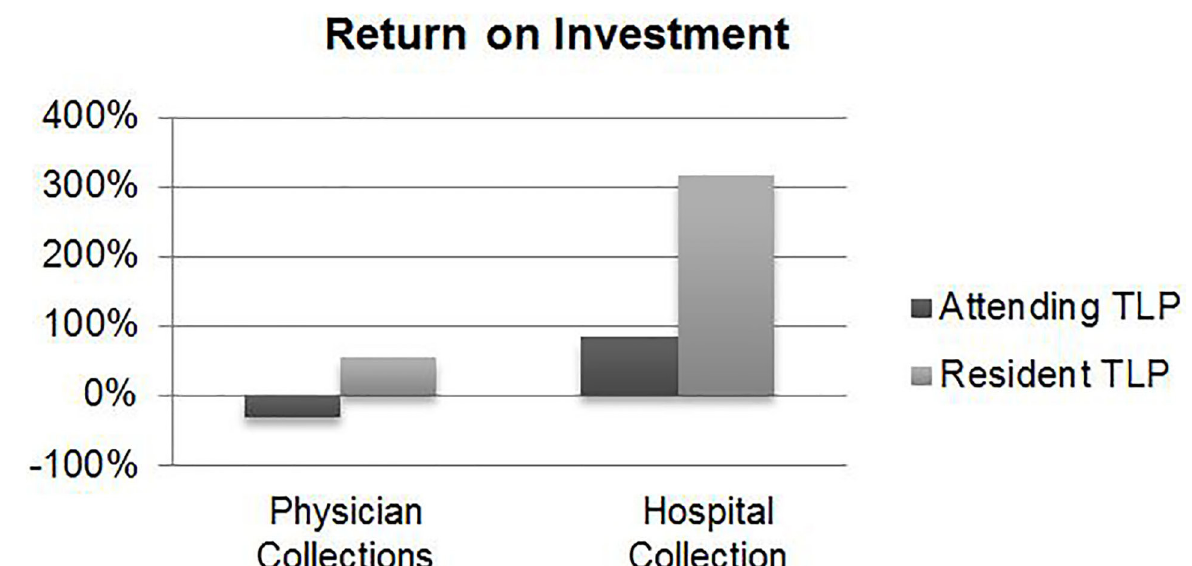
Figure 2. Difference in return on investment for attending triage liaison provider (TLP) and resident TLP, through physician collections and hospital